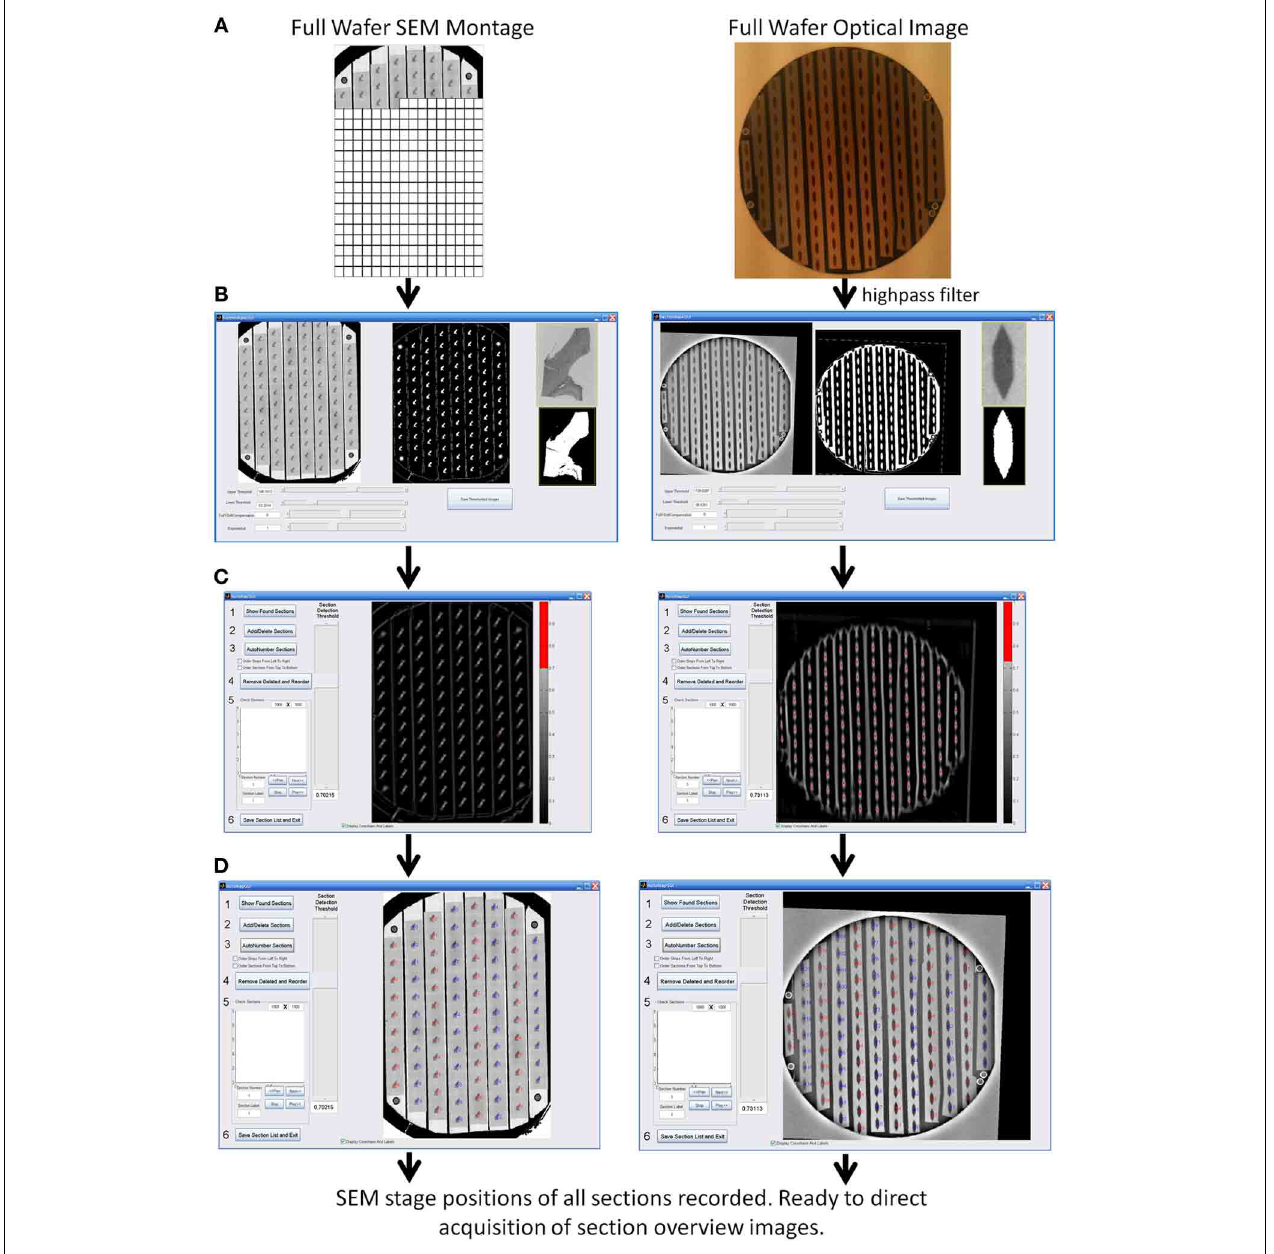
FIGURE 4 | WaferMapper process steps for automatically finding the positions of all sections on a wafer. (A) Acquisition and registration of a full wafer image to the SEM stage using either a full wafer SEM montage (left) or a full wafer unprocessed optical image (right). (B) Thresholding of full wafer image and example section image creating binary masks. (C) Convolution of